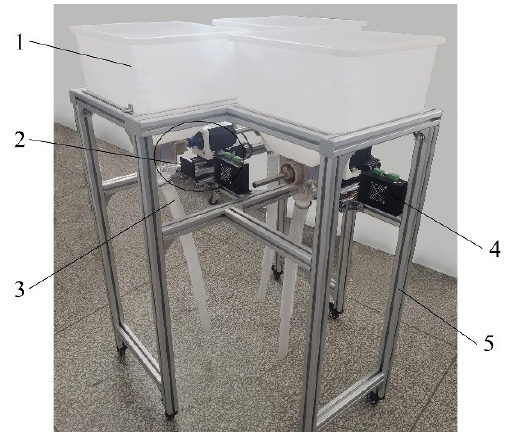
Figure 11. Test bench: 1, fertilizer tank; 2, bivariate fertilizer discharge device; 3, fertilizer discharge pipe; 4, motor drive; 5, mounting frame.